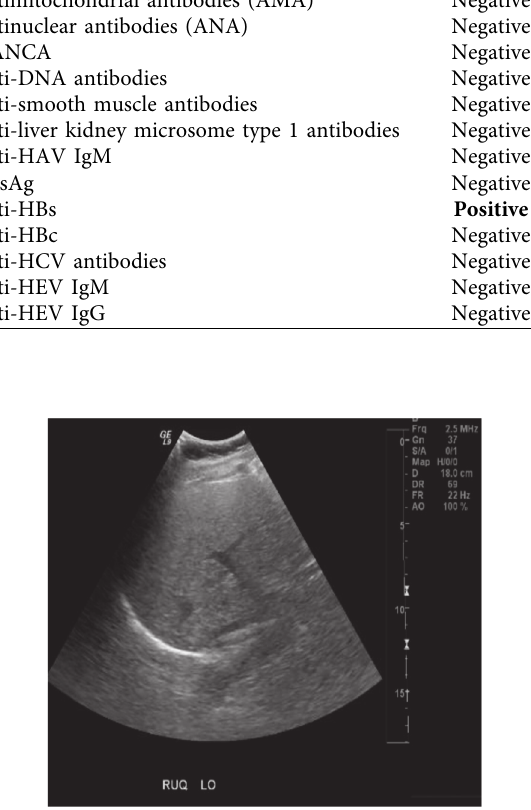
Figure 2: Abdominal ultrasound showing fatty liver.